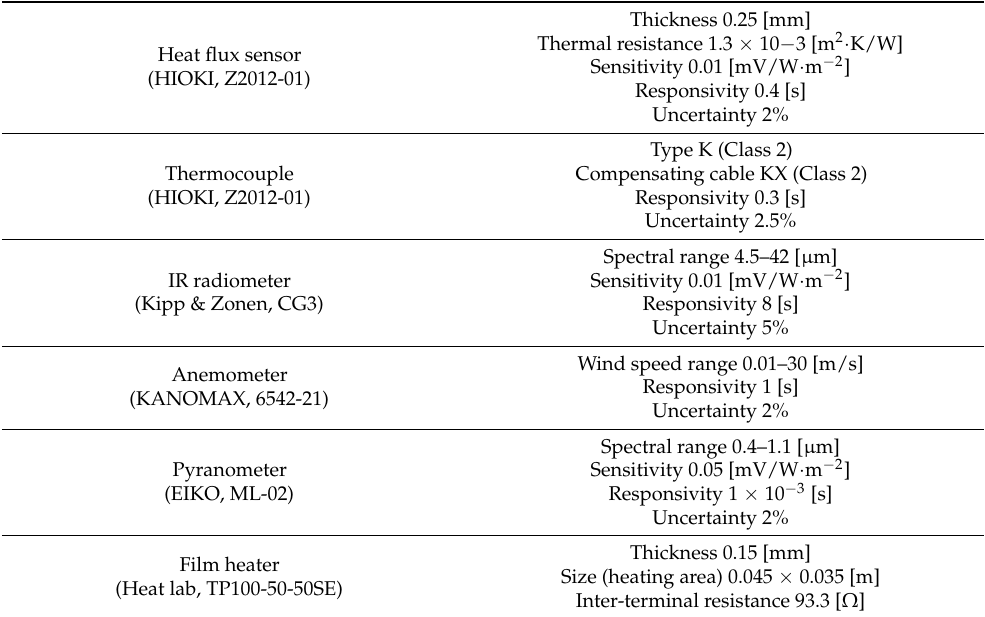
Figure 1. Shape of the experimental vehicle: small van ( top ), sedan ( bottom ). Table 1. Specifications of the sensors